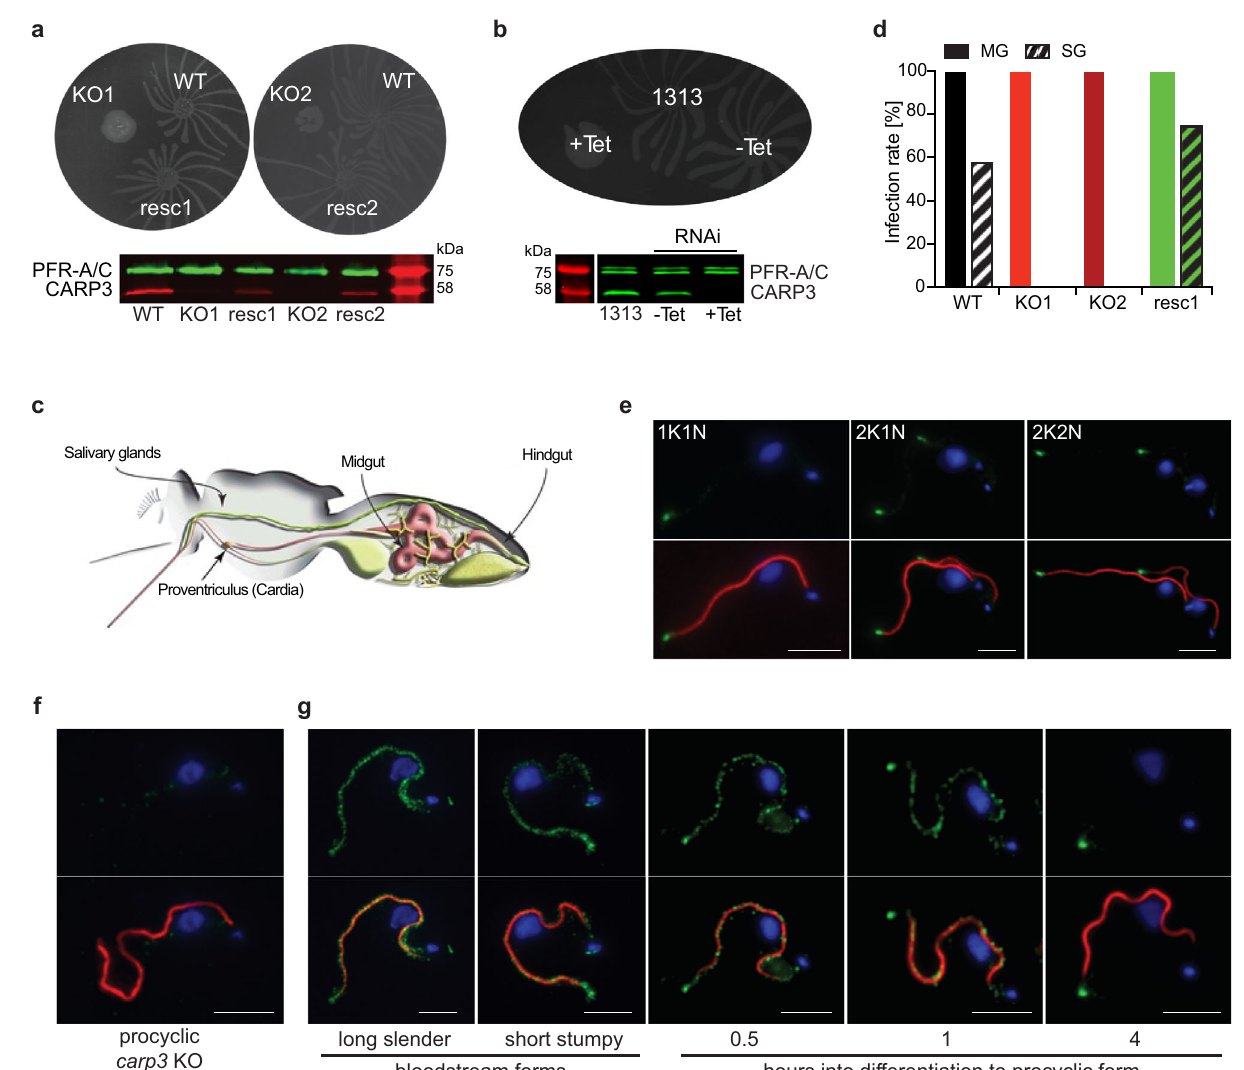
Fig. 1 | CARP3 is a fl agellar tip regulator of social motility (SoMo) and is essentialforcolonizationoftsetse fl ysalivaryglands.a SoMoassaysofprocyclic T. brucei AnTat 1.1 wild type (WT), carp3 knock-out (KO, independent clones KO1, KO2) or in situ CARP3 rescue (resc, independent clones resc1, resc2). The Western blotwasprobedwithanti-CARP3andanti-PFR-A/C(loading control). b SoMoassay upon tetracycline (Tet)-inducibleRNAiof CARP3 (-Tet / +Tet 24h) and the parental AnTat 1.1 1313 cell line. The Western blot shows CARP3 repression detected by antibodiesasin( a ). c Illustrationofthedigestivesystemandthesalivaryglandsofa tsetse fl y (adapted from 91 ). d Infection rates of tsetse fl y midgut (MG) or salivary glands (SG) with T. brucei AnTat 1.1 cell lines as in ( a ). Flies were dissected